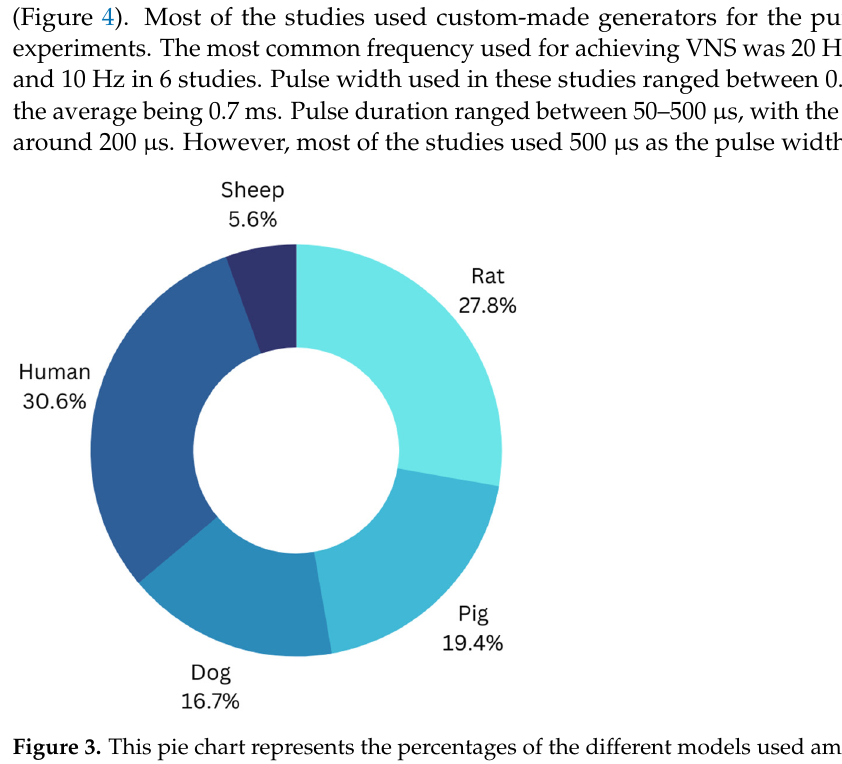
Figure 4. This bar chart represents the frequency of various VNS devices used among the studies (n = 35).